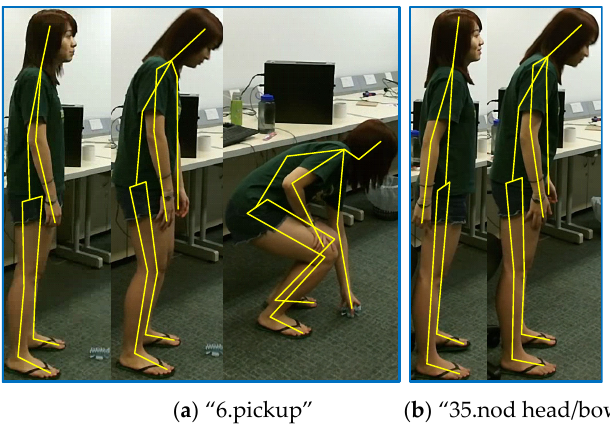
Figure 9. Two examples for class “6.pickup” and class “35.nod head/bow”.